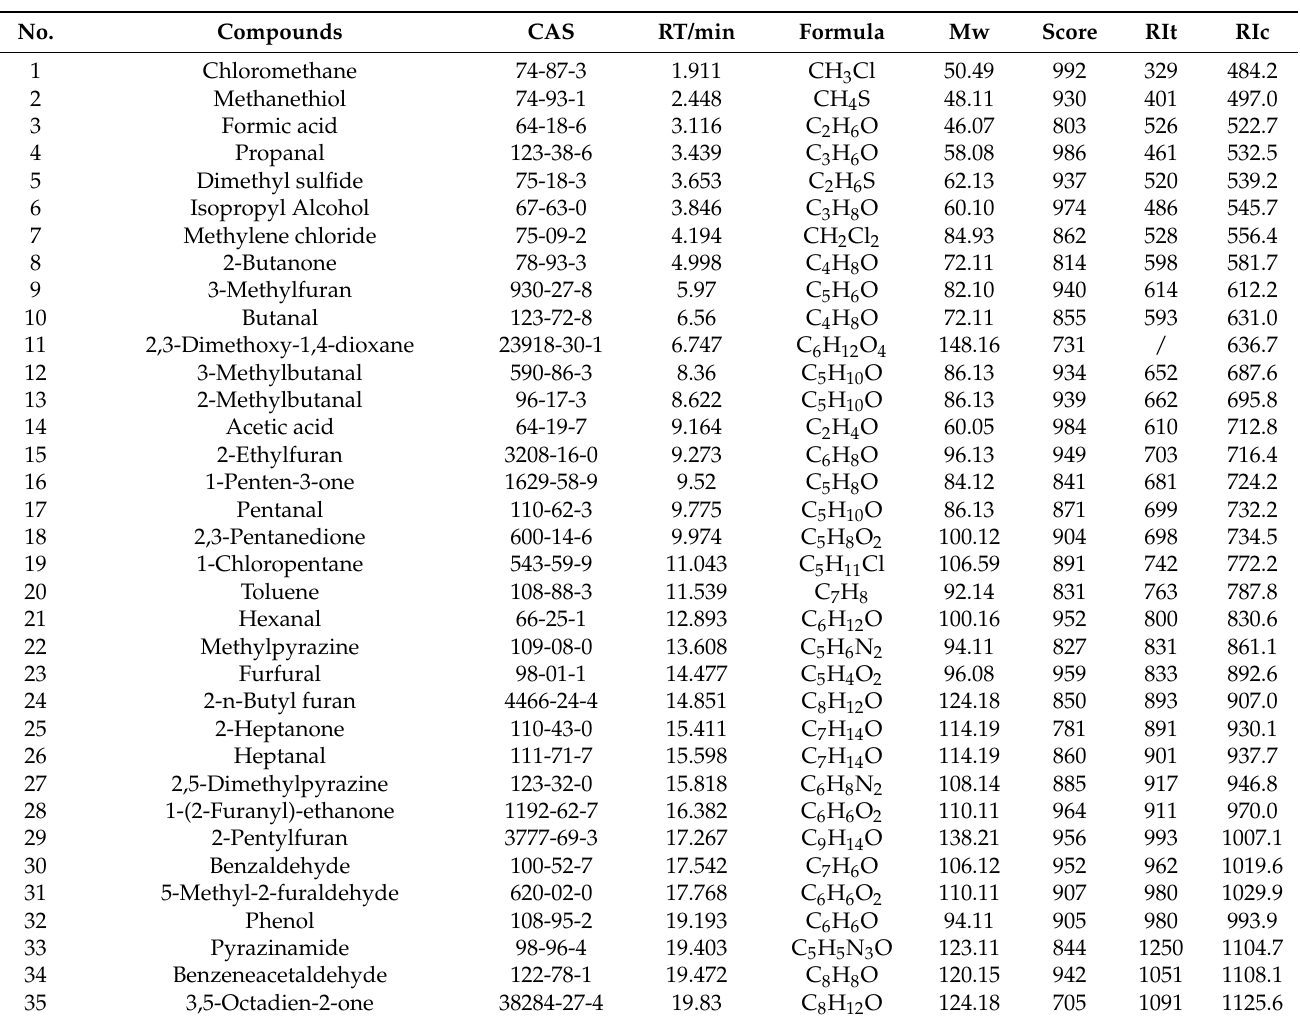
Table 2. A total of 49 volatile compounds were identified from burdock root 1